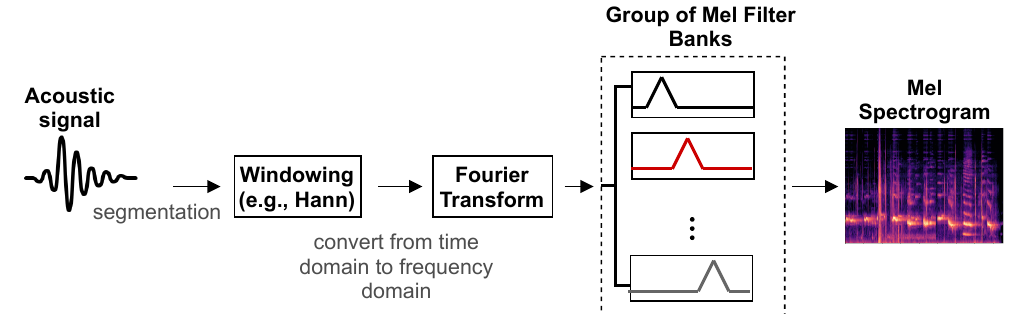
Figure 1. The process of extracting the Mel spectrogram from an acoustic signal, where the output of each Mel filter is summed then combined to create the Mel spectrogram, which is visualized in terms of the amplitude of the frequency components over